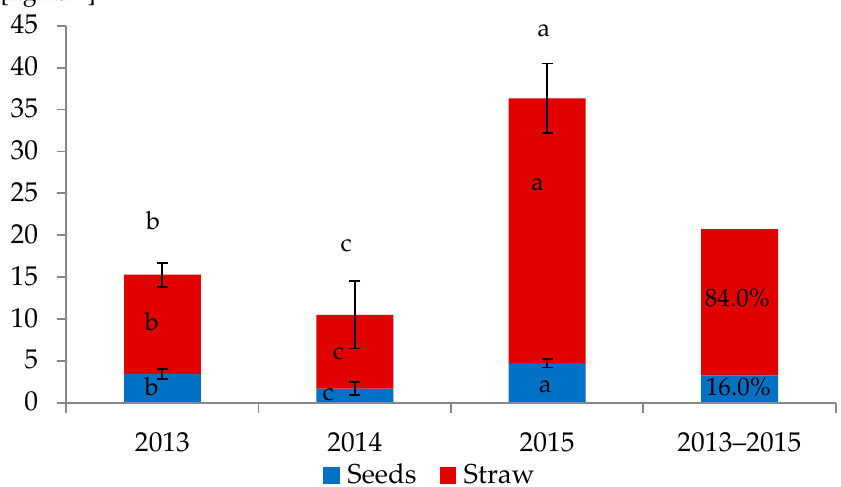
Figure 6. Calcium accumulation (kg ha − 1 ) in whole faba bean plant (average for years). The vertical line atop bar is SD for that mean. Different letters indicate a significant difference (Tukey’s multiple range test).